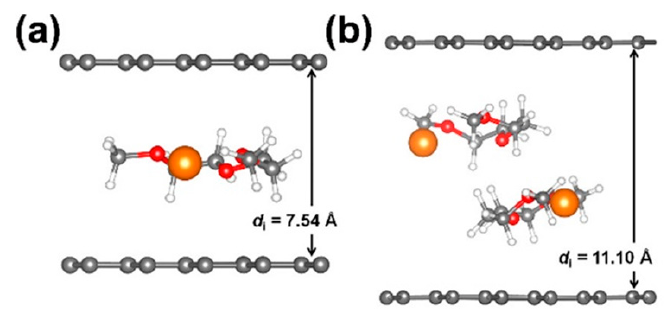
Figure 6. Model of a Mg 2 + –DEGDME cointercalated graphite: ( a ) single- and ( b ) double-layer structures. Orange, white, gray, and red spheres represent Mg, H, C, and O atoms, respectively. d i represents the intercalant gallery height (figure reproduced from reference [81] with permission.).